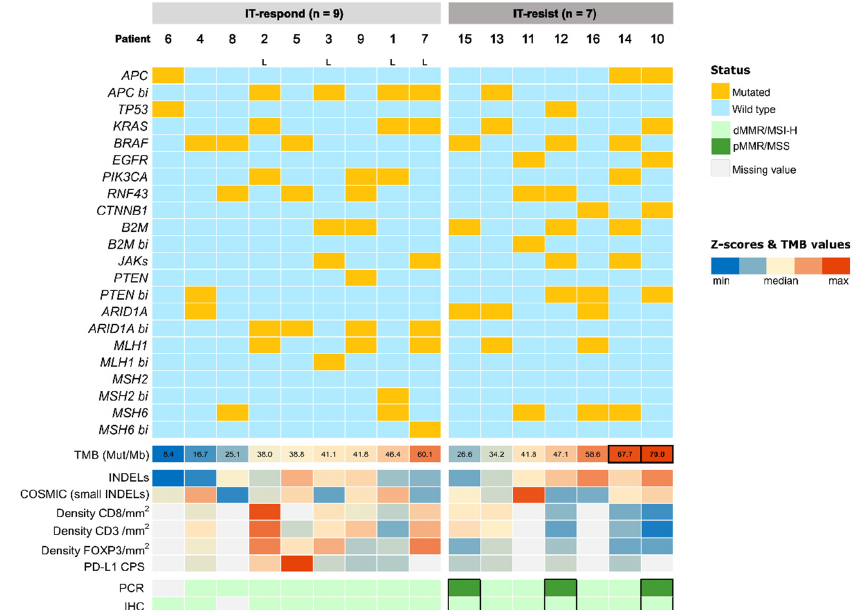
Figure 3. Representative heatmap of the entire cohort, including genomics (mutational profile— monoallelic and biallelic mutations are shown separately for a given gene, TMB, indels ratio and small indels COSMIC signature), immune microenvironment (CD3 + , CD8 + and FOXP3 + densities and PD-L1 CPS), and MSI/MMR status evaluation through IHC and PCR, according to IT-responder and IT-resistant. Bi: biallelic. L: Lynch syndrome.